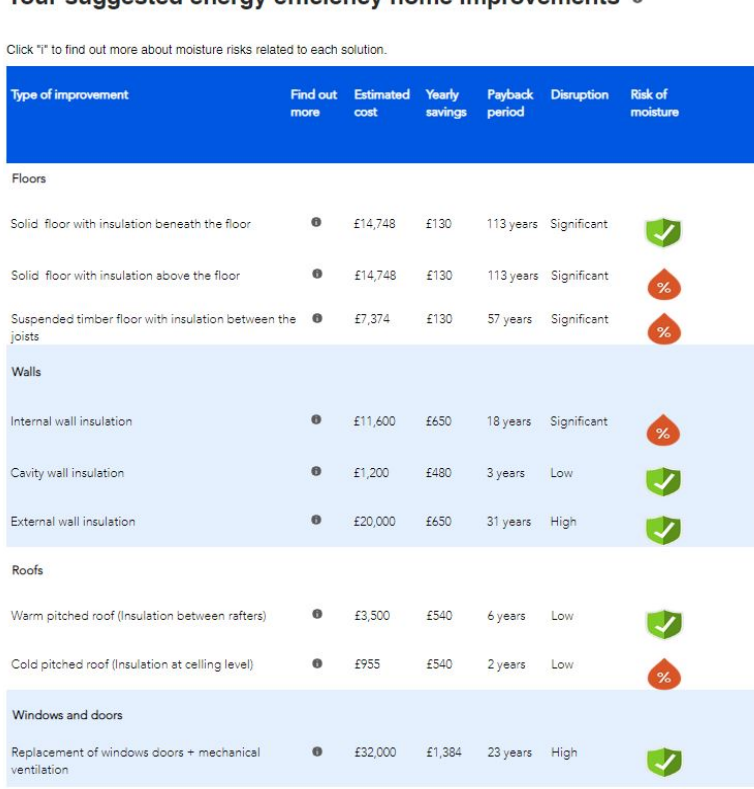
Figure 7. Your suggested energy efficiency home improvements